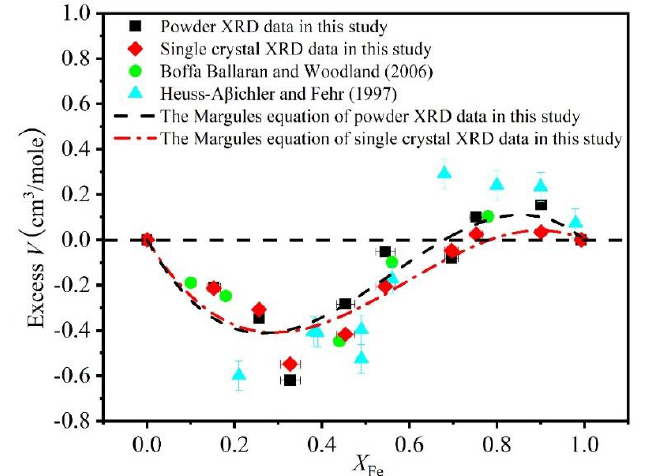
Figure 4. Excess volumes of mixing in grossular–andradite solid solution. A negative deviation was observed in Al-rich samples for all studies. The dashed line is fitted using single-crystal XRD data by two-parameter Margules